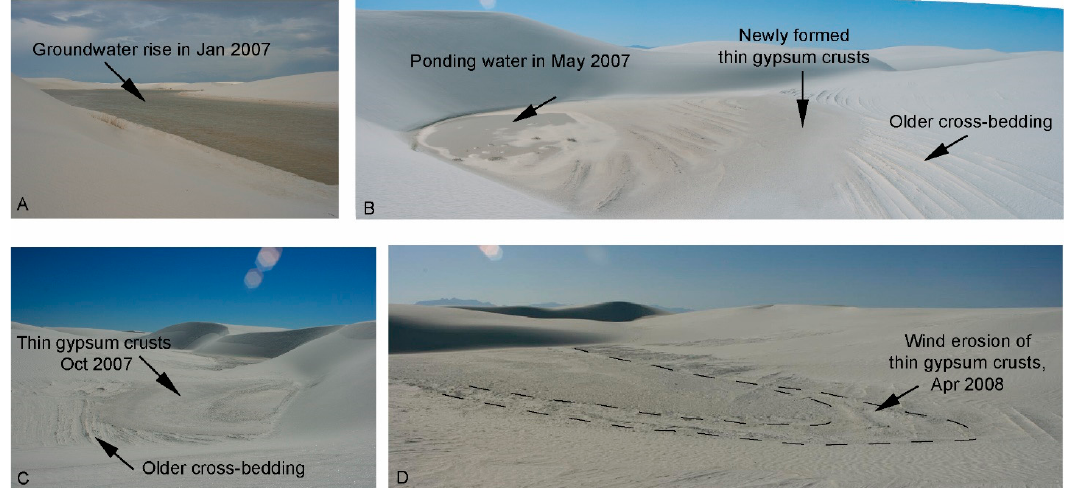
Figure 3. Surface features associated with groundwater rise in the White Sands interdunes during the winter of 2006/2007 (Photographs taken by A. Szynkiewicz). ( A ) ponding water in the center of White Sands dune field (January 2007). ( B , C ) newly formed thin gypsum crusts after groundwater rise and water ponding in the interdunes (May and October 2007). ( D ) subsequent wind erosion of thin gypsum crusts (April 2008) exposing older cross-bedding strata preserved by previous episodes of groundwater rise.